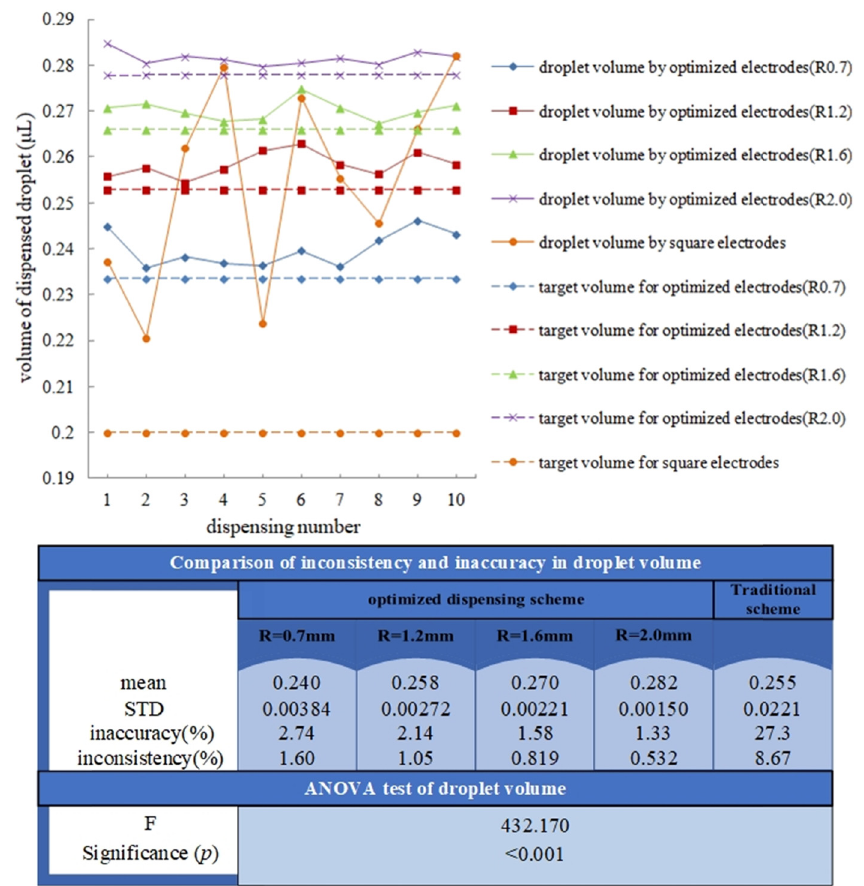
Figure 8: The volume of the dispensed droplets for optimized electrodes and traditional square electrodes.